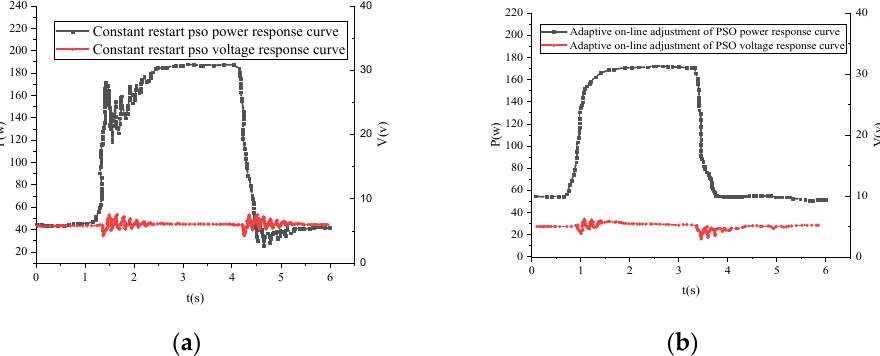
Figure 9. Experimental control results of the PSO algorithms: ( a ) FVR-PSO response curve; ( b ) AOA- PSO response curve.